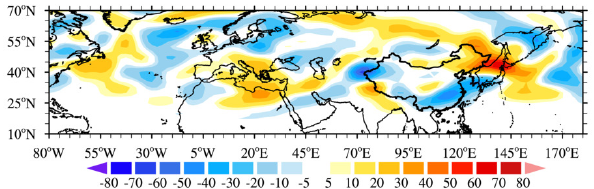
Figure 5. Composite map of the Rossby wave source (shading, unit: s − 2 ) at 200hPa for the 13 SR–NH events. According to Eq. (4), the variables should be composited first and then used to calculate the Rossby wave source; hence, there is no t test